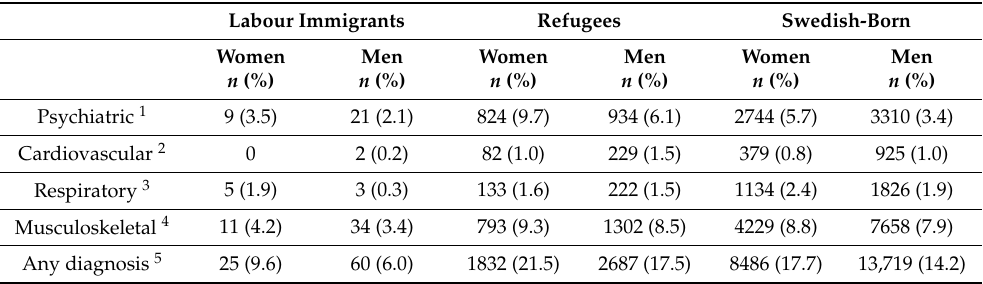
25 (9.6) 60 (6.0) 1832